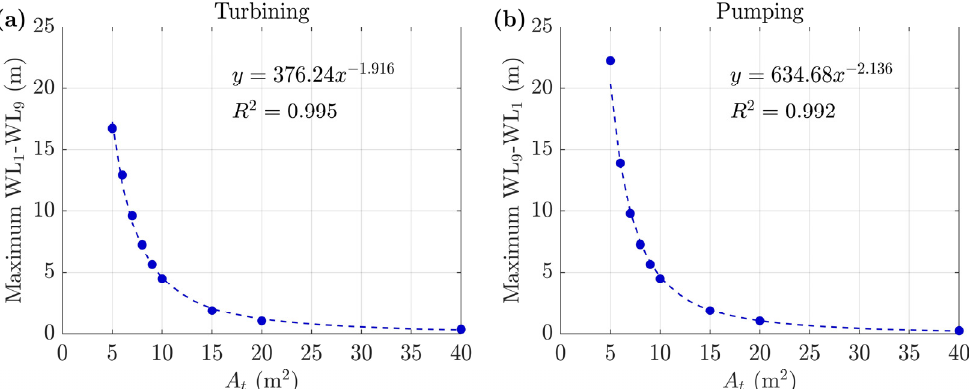
scenario. Successive chambers are connected with two galleries with roughness height equal to 5 cm.